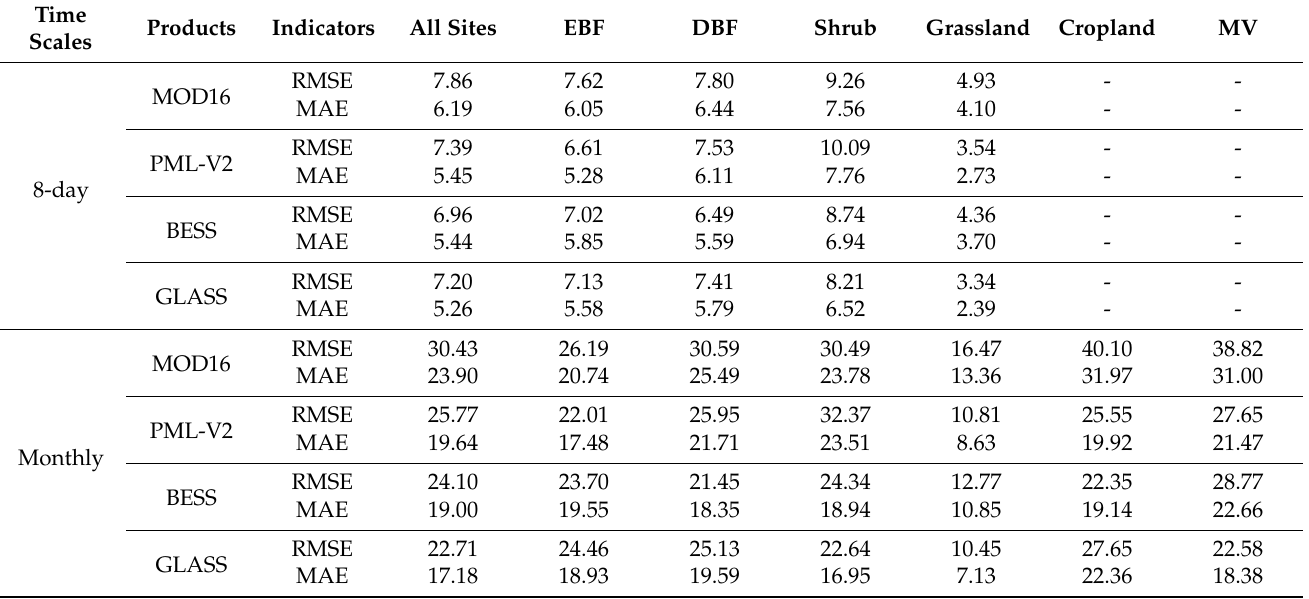
Table 5. Evaluation results of ET products in diverse vegetation